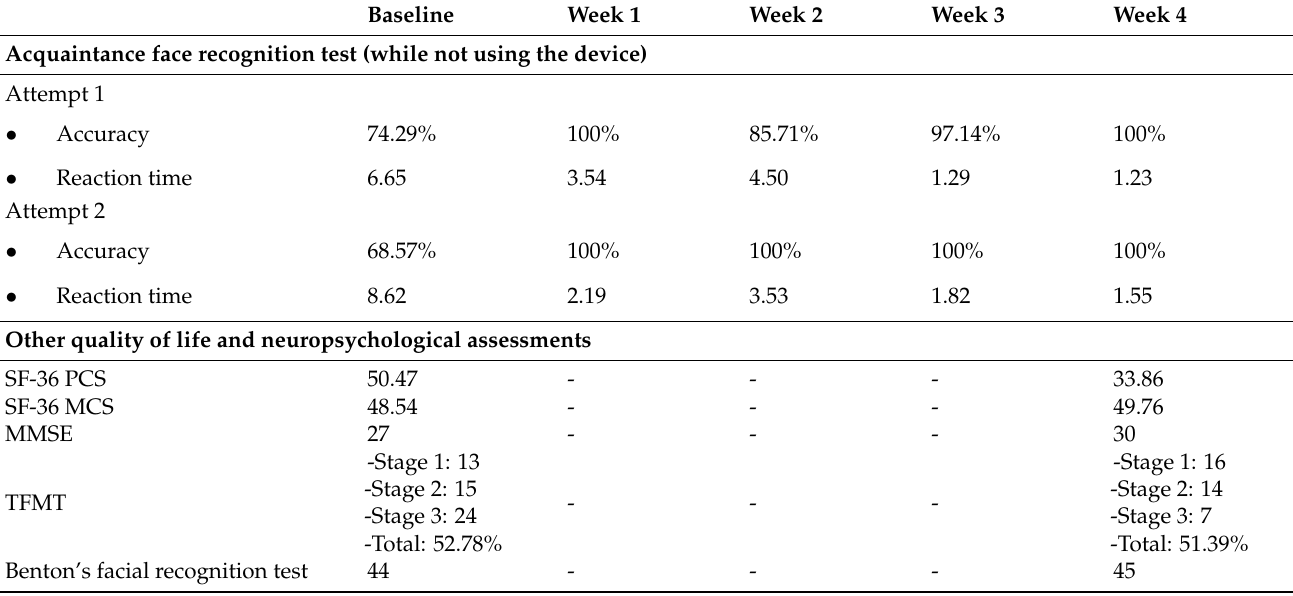
Table 2. Quality of life and selected neuropsychological assessments follow-up data in the patient.